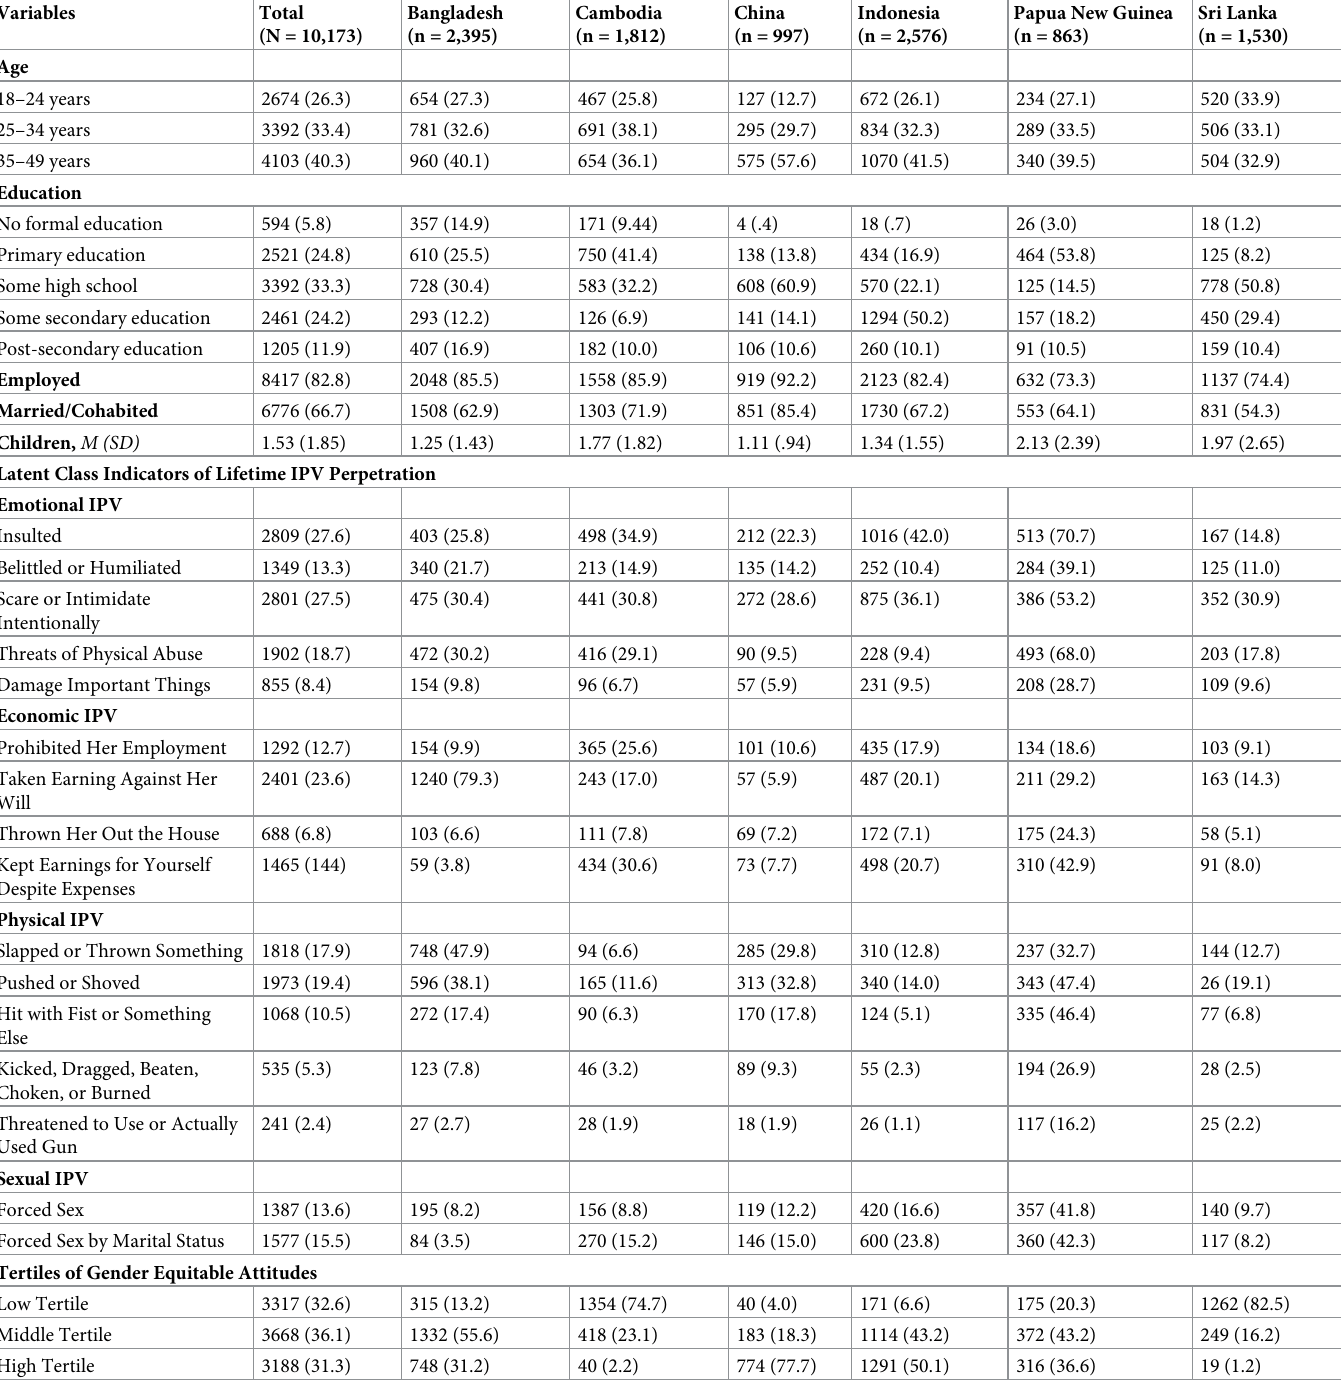
Table 1. Prevalence of demographics, lifetime IPV perpetration and gender equitable attitudes categories among male participants recruited for UN Multi-Country Study on Men and Violence (total sample and by